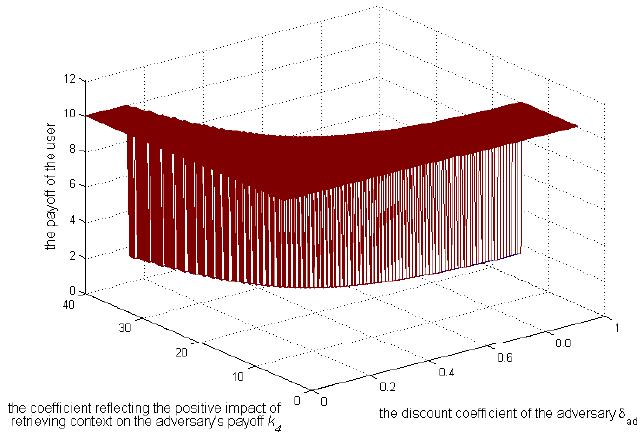
Figure 12. Impact of k 4 and δ ad on the user’s